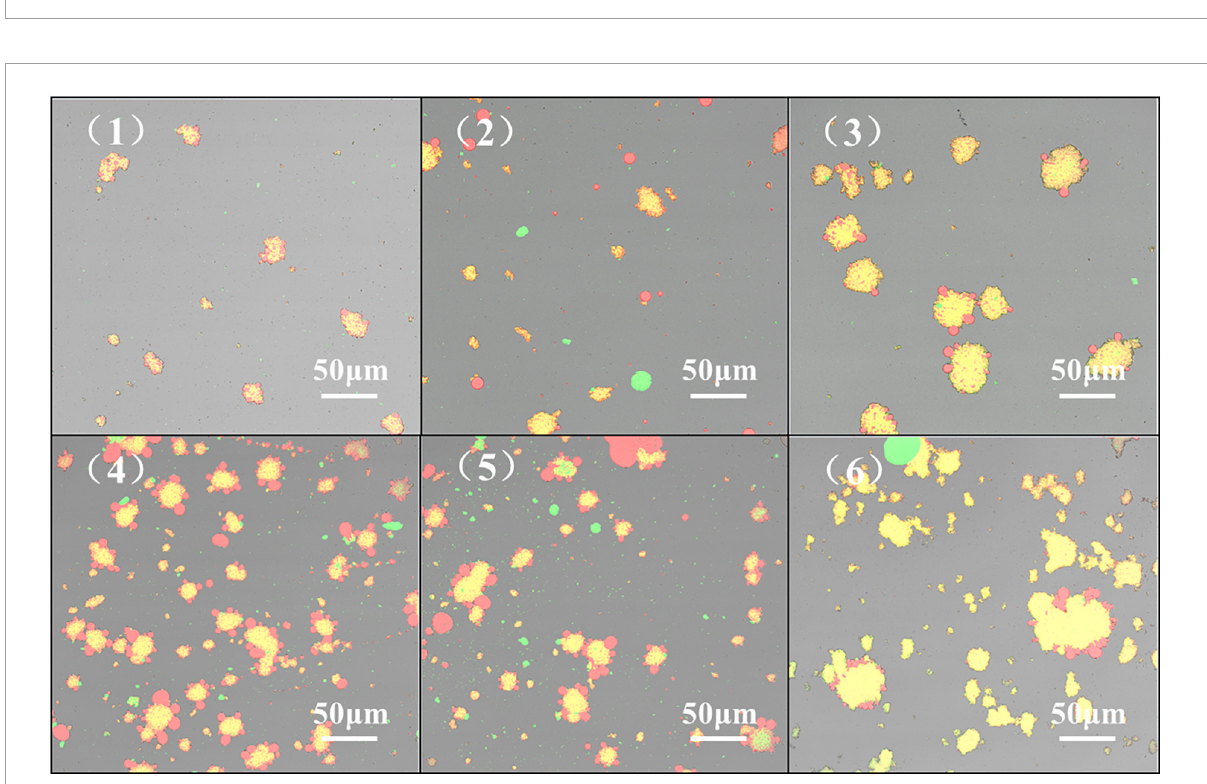
FIGURE8 Effects of high-pressure homogenization (HPH) on the emulsifying activity (EA) and emulsifying stability (ES) of enzymatic hydrolyzed soybean protein concentrate (SPC).